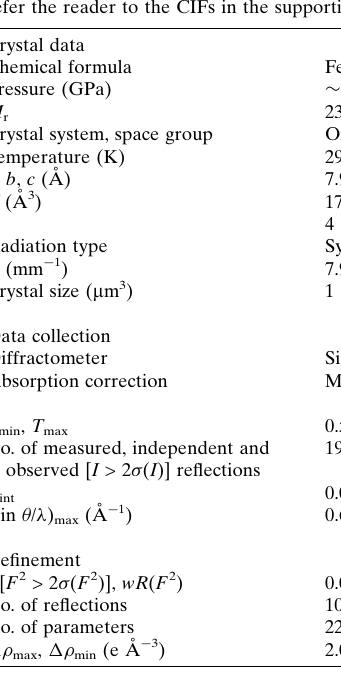
Data collection